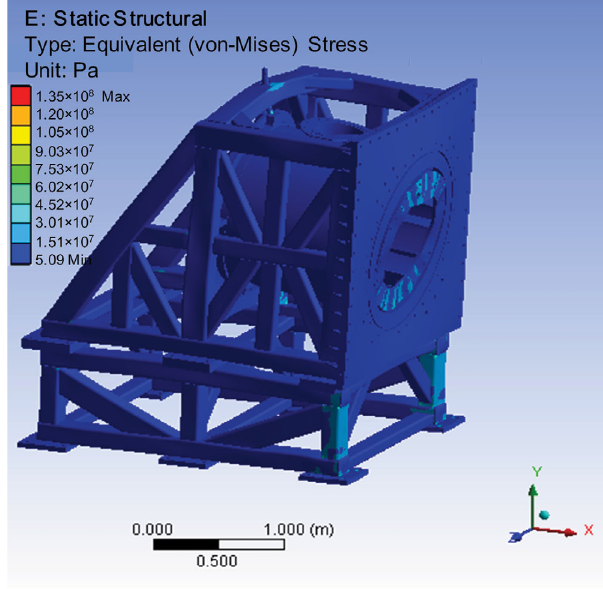
taking all load into consideration. Results show a maximum stress of 135 MPa presents on the structure, which is within the material limit and the design is structurally